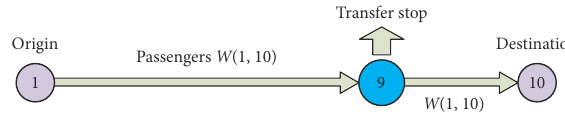
Figure 11. Transfer route of O–D pair (1, 10) under β ij = 0 (corresponding to Figure